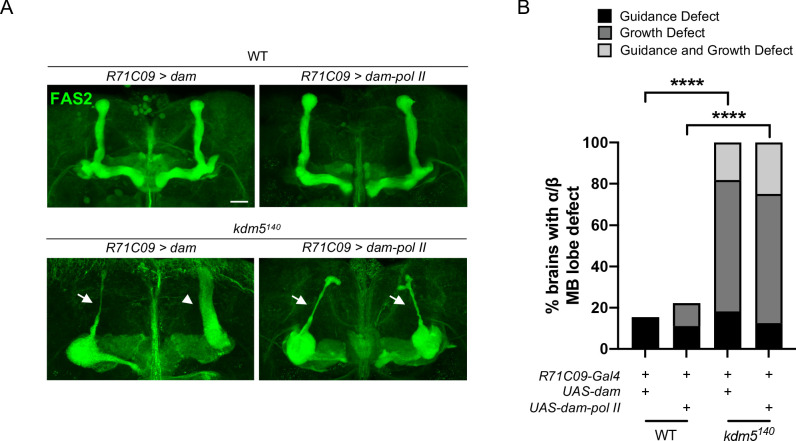
kdm5140 pharate adults expressing targeted DamID (TaDa) genetic elements present with significant mushroom body (MB) morphological defects.(A) Representative α/β lobe Z projections of pharate kdm5140 animals expressing TaDa genetic elements and their respective controls. The antibody anti-fasciclin 2 is used to visualize α/β lobes. Arrows indicate growth defects. Scale bar represents 20 μm. (B) Quantification of α/β lobe defects in pharate kdm5140 animals expressing TaDa genetic elements and their respective controls. n = 8–22 (mean n = 13). ****p<0.0001 (chi-square test with Bonferroni correction).